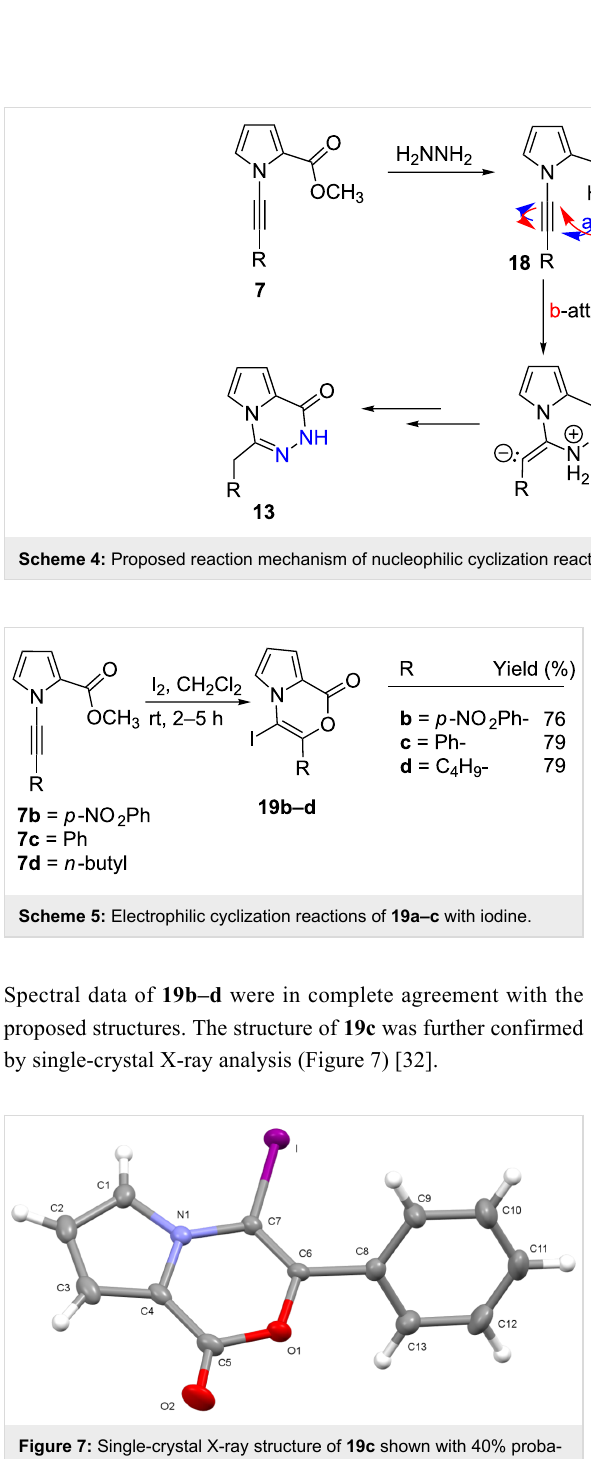
The following reaction mechanism was proposed for the forma- tion of 19c (Scheme 6). The reaction starts with the π -activa- tion of the triple bond by iodine to form the intermediate 20 , which undergoes an intramolecular addition of the ester oxygen atom to the alkyne functionality to form the intermediate 21 . In the next step, a nucleophilic attack on the methyl group by iodide forms the product 19c